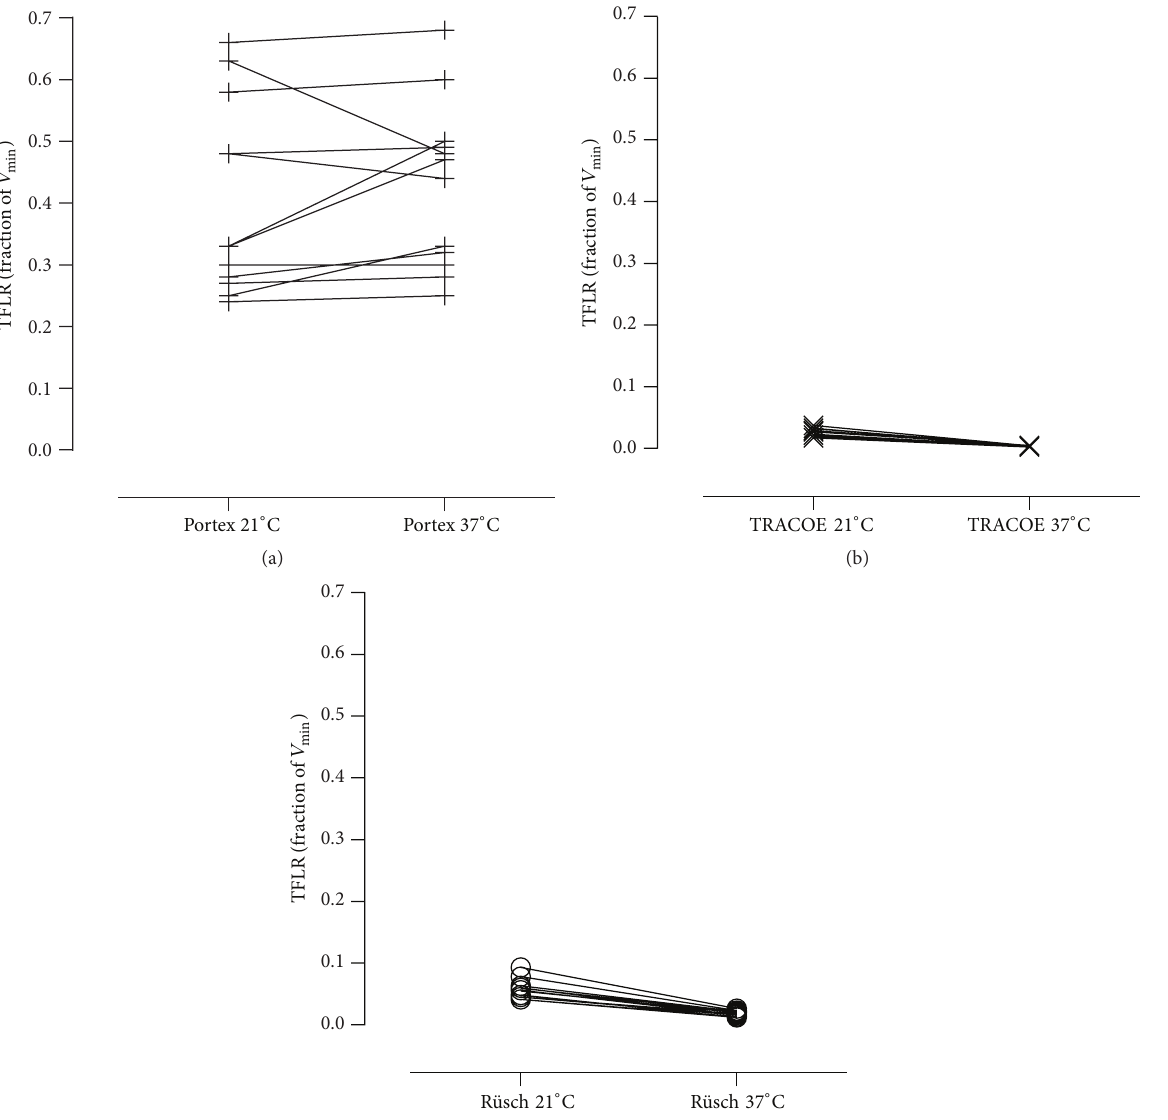
experimental conditions. Additionally, variations in TFLR and TFP were observed for each tracheostomy tube as the experimental conditions were